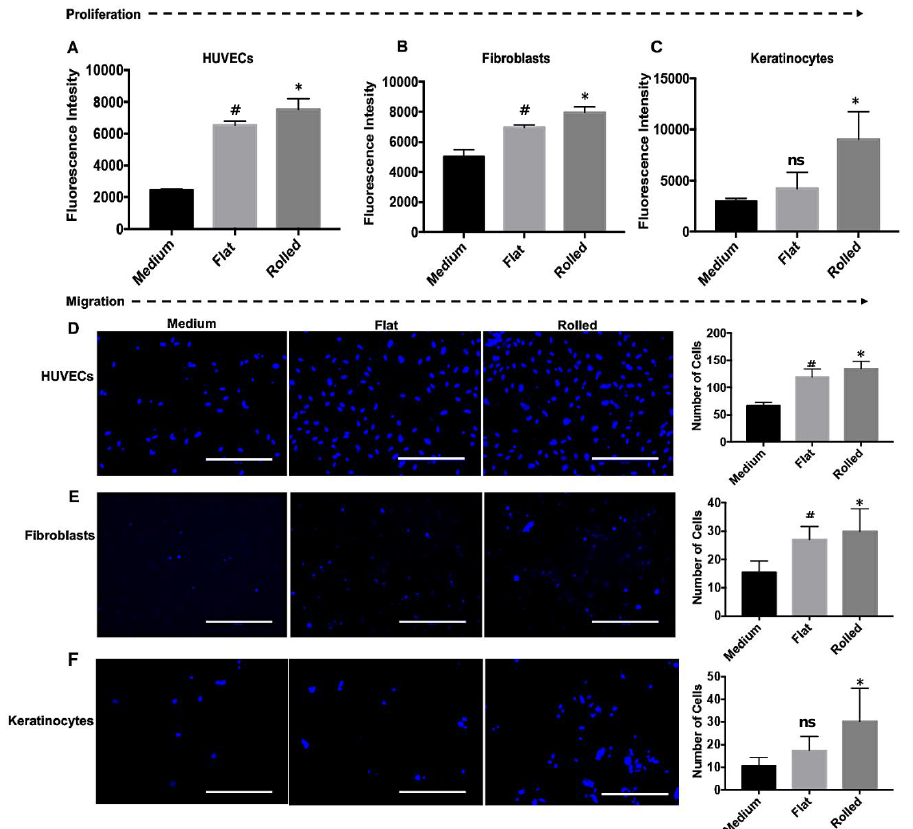
Figure 5. Characterization of conditioned medium from DC scaffolds for proliferation and migration of cells. The conditioned media collected from the flat and rolled scaffold culture conditions were tested for their bioactivity. An alamarBlue assay was performed to obtain proliferation data on ( A ) HUVECs ( n = 6, Rolled vs. Flat p < 0.05; Rolled vs. Medium p < 0.0001; Flat vs. Medium p < 0.0001), ( B ) primary human skin fibroblasts ( n = 6, Rolled vs. Flat p < 0.05; Rolled vs. Medium p < 0.0005; Flat vs. Medium p < 0.001), and ( C ) primary human skin keratinocytes ( n = 6, Rolled vs. Flat p < 0.001; Rolled vs. Medium p < 0.0002; Flat vs. Medium p > 0.05) 24 h after the addition of CM to their culture media. Eight micrometer pore size trans-wells were used to determine migration of ( D ) HUVECs ( n = 4, Rolled vs. Flat p > 0.05; Rolled vs. Medium p < 0.0001; Flat vs. Medium p < 0.0005), ( E ) primary human skin fibroblasts ( n = 4, Rolled vs. Flat p > 0.05; Rolled vs. Medium p < 0.02; Flat vs. Medium p < 0.05), and ( F ) primary human skin keratinocytes ( n = 4, Rolled vs. Flat p > 0.05; Rolled vs. Medium p < 0.04; Flat vs. Medium p > 0.05) in response to the CM over 4 h of incubation time. The cells migrated were stained with dapi and counted to obtain the total number of cells migrated. The scale bar represents 200 µ m. SmGM-2 medium from the acellular sca ff old was used as a control. Statistical analysis was performed using one-way ANOVA. * and # denote statistical significance, and ns represents no